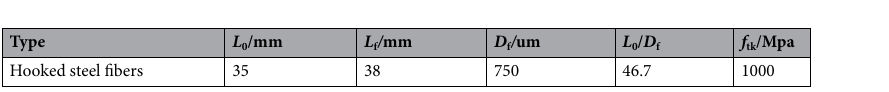
Table 2. Basic parameters of hooked steel fiber. L 0 is effective length; L f is physical length; D f is the effective diameter; f tk means tensile